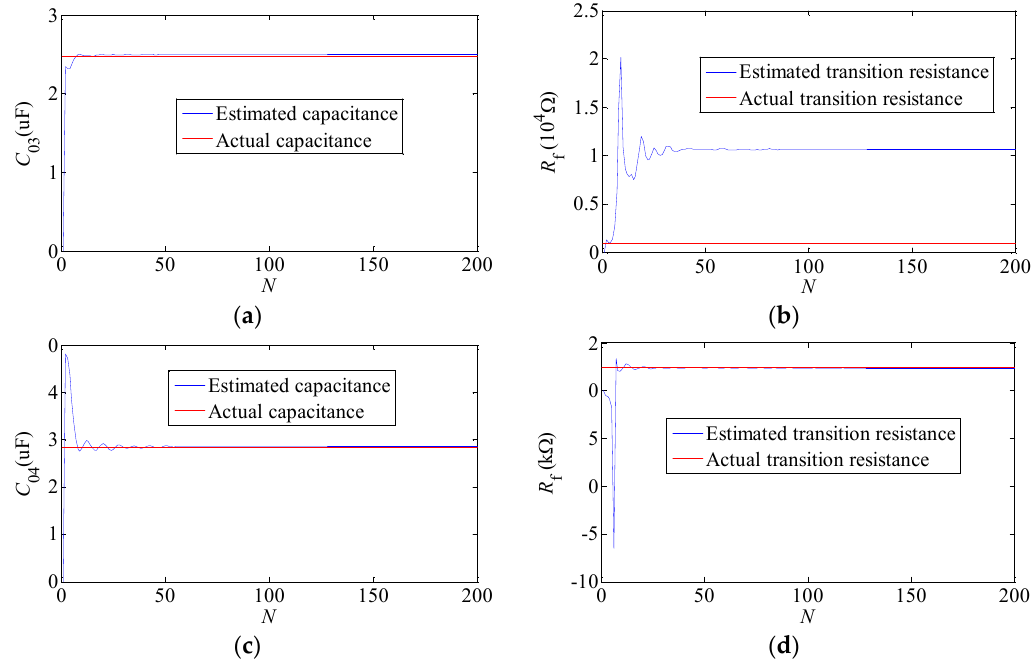
Figure 8. Estimated capacitances and transition resistances of feeder 1 and feeder 2 for a single-phase HIF in K4 point. ( a ) Estimated capacitance of feeder 3; ( b ) Estimated transition resistance of feeder 3; ( c ) Estimated capacitance of feeder 4; and ( d ) Estimated transition resistance of feeder 4.